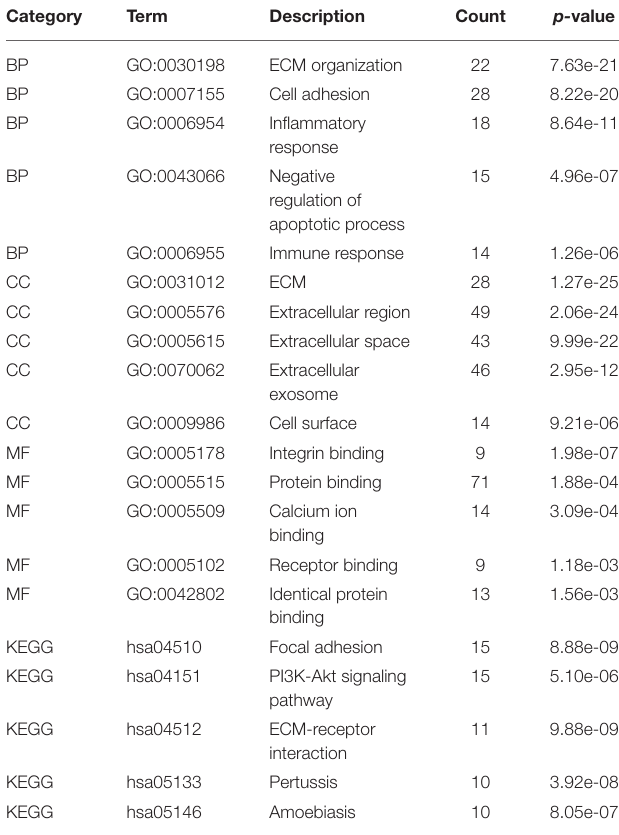
TABLE 2 | Enrichment analysis of the 104 differential immune-related genes.